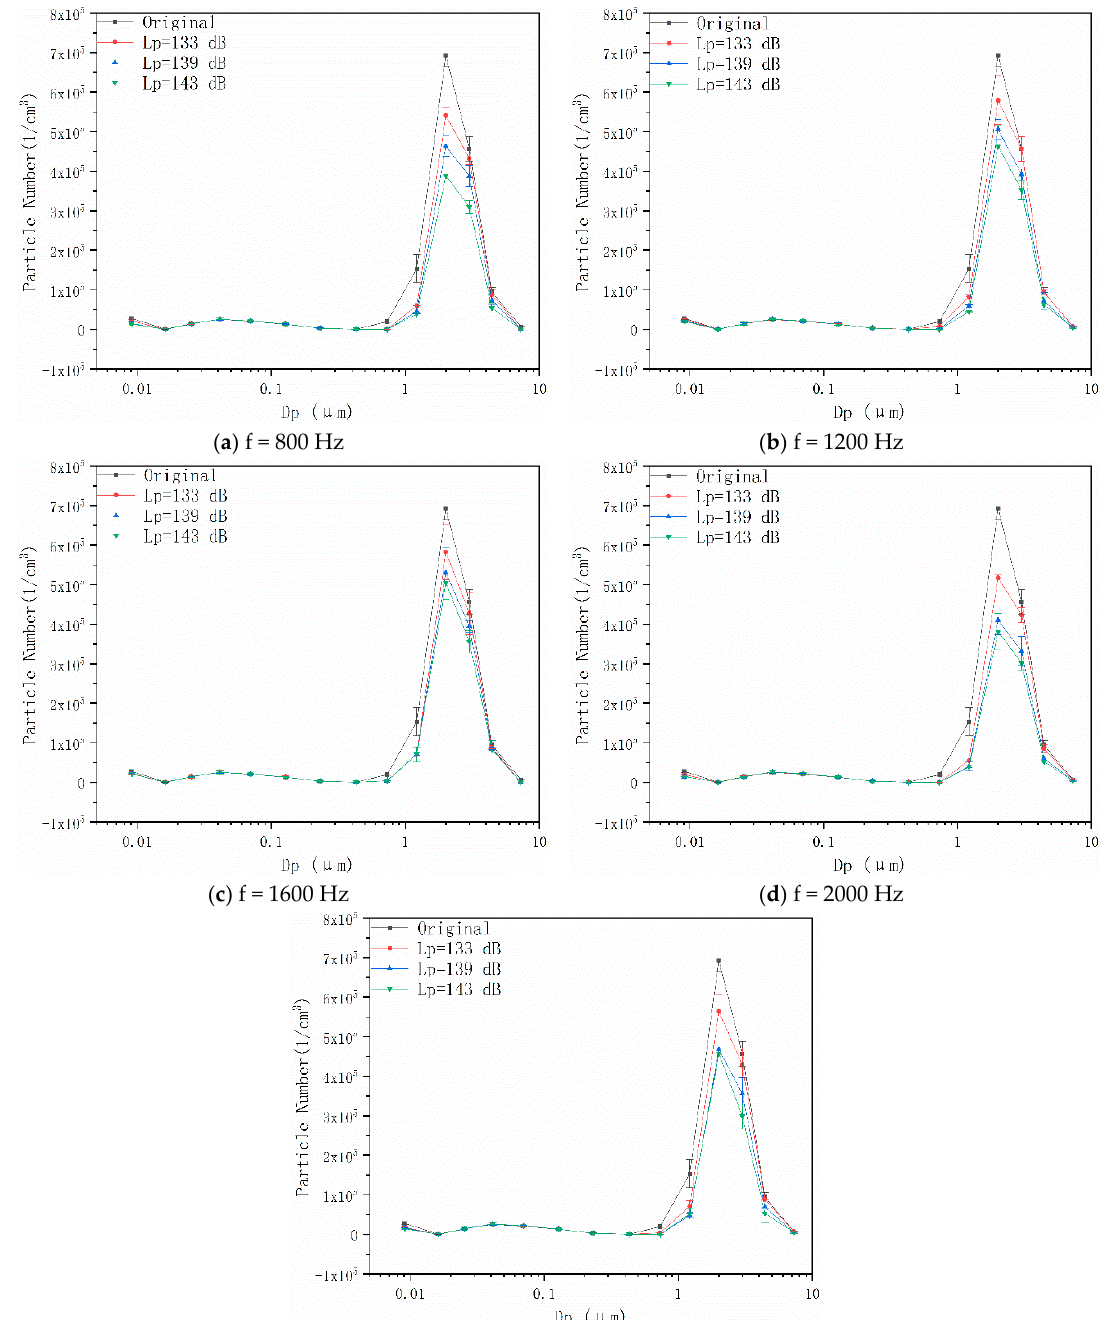
Figure 6. Effect of SPLs on 2- μ m particles at different frequencies in acoustic agglomeration. Figure 6. E ff ect of SPLs on 2- µ m particles at di ff erent frequencies in acoustic